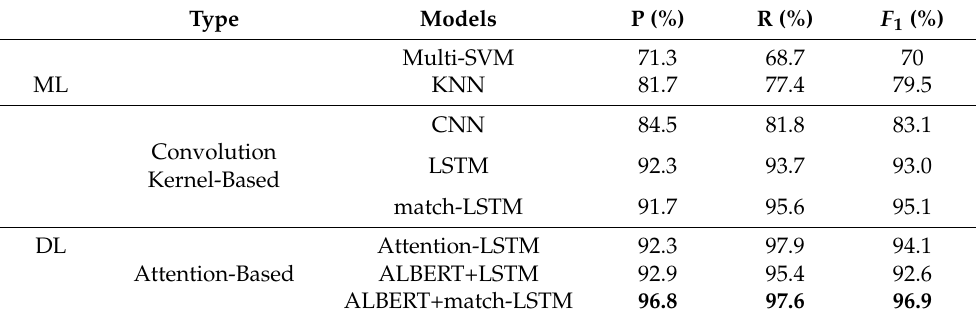
Table 7. Evaluation of different models on